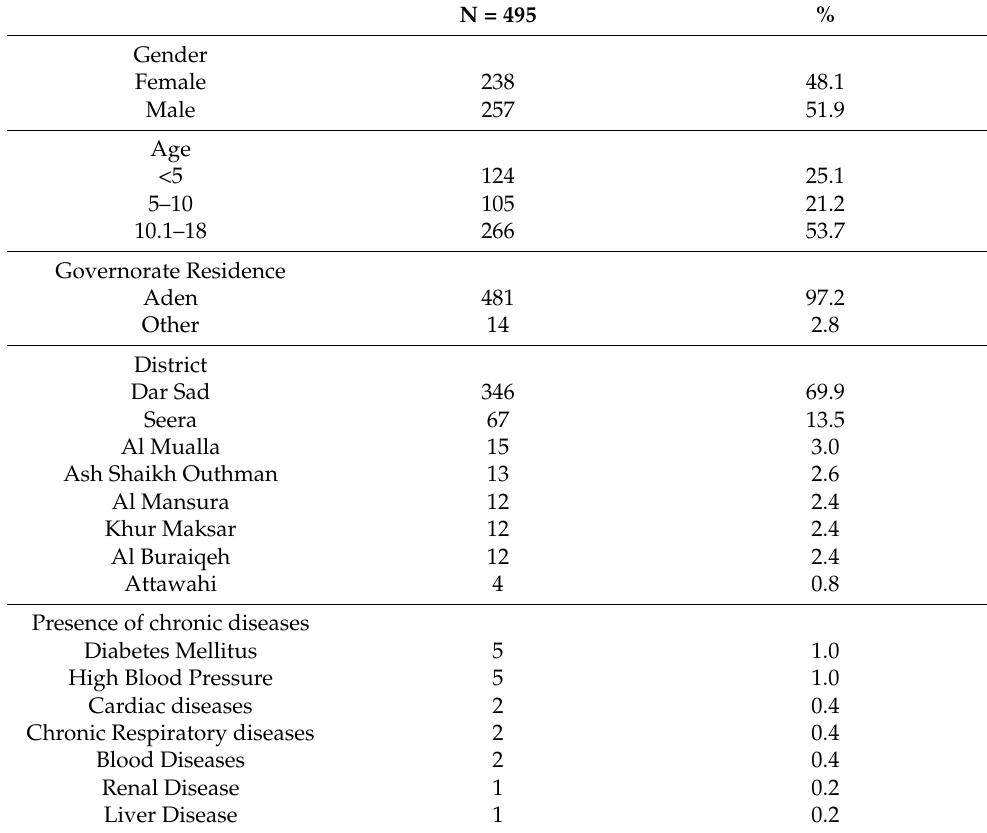
Table 1. Sociodemographic and Health Characteristics of COVID-19 Suspected Children.